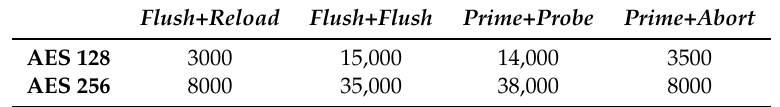
Table 2. Mean number of samples required to retrieve the whole key in non-virtualized environments.